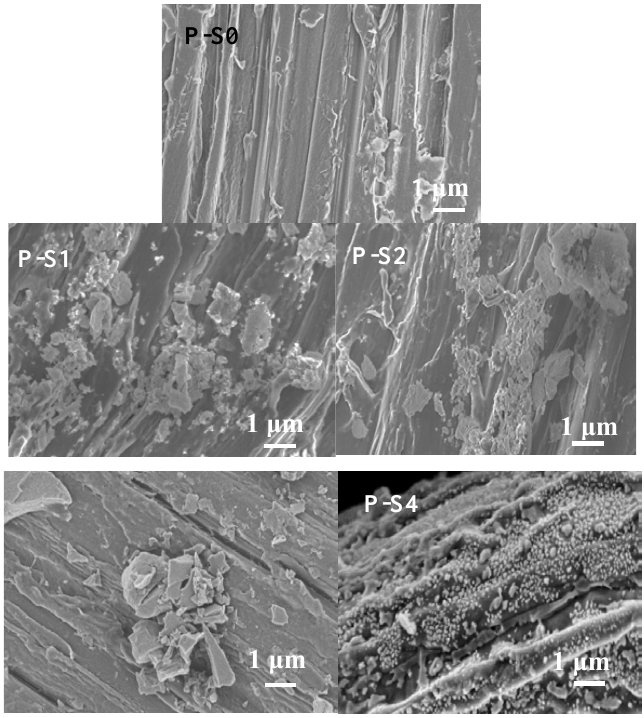
Figure 3. Scanning electron microscopy (SEM) images of P-S0, P-S1, P-S2, P-S3, and P-S4.